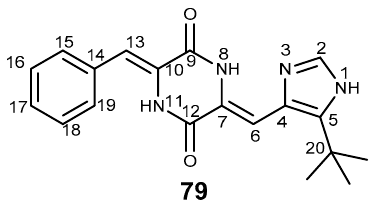
Figure 16. Structure of plinabulin ( 79 ).